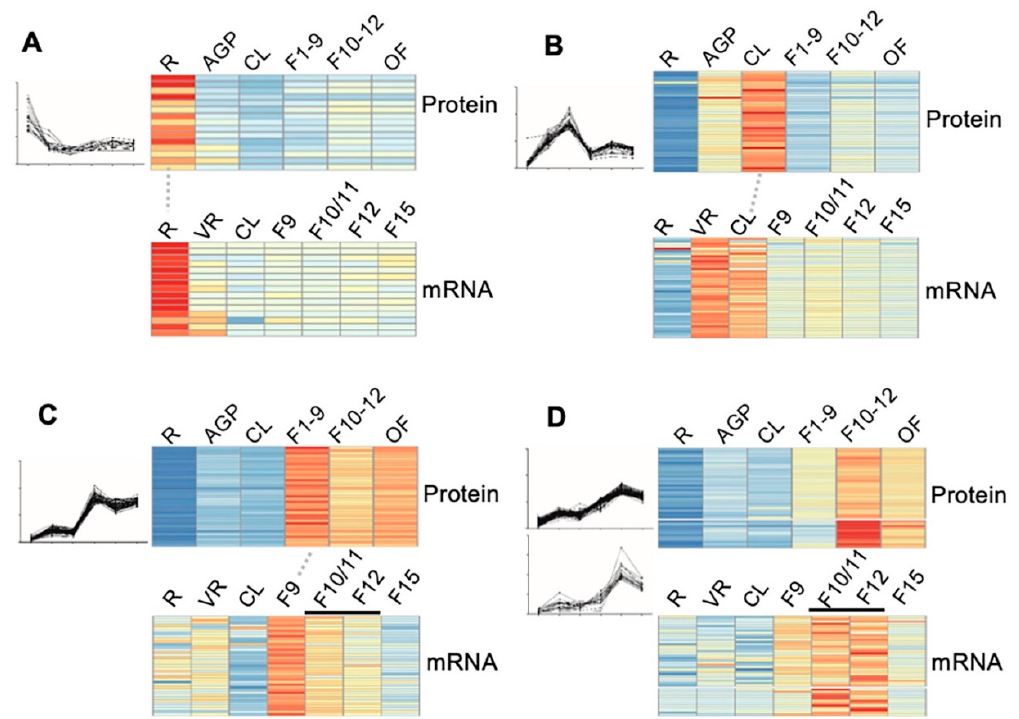
Figure 5. Correlation of the dynamic expression pattern between the protein level and the mRNA level. ( A – D ) The expression of the 17 root preferentially expressed ( A ), the 40 cauline leave (CL)-preferentially expressed ( B ), the 37 stage 1–9 flower (F1–9) preferentially expressed ( C ), and 43 stage 10–12 flower (F10–12) preferentially expressed ( D ) proteins and their correlated transcriptomic data from the eFP database (http: // bar.utoronto.ca / efp / cgi-bin / efpWeb.cgi). R, 14-day-old roots; AGP, 14-day-old above ground part tissues; CL, cauline leaves; F1–9, stage 1–9 flower buds; F10–12, stage 10–12 flower buds; OF, opened flowers; VR, vegetative tissue; F10 / F11, stage 10 or stage 11 flowers; F12, stage 12 flowers; F15, stage 15 flowers. The red, yellow and blue denote the high, medium, and low expression level of proteins respectively.